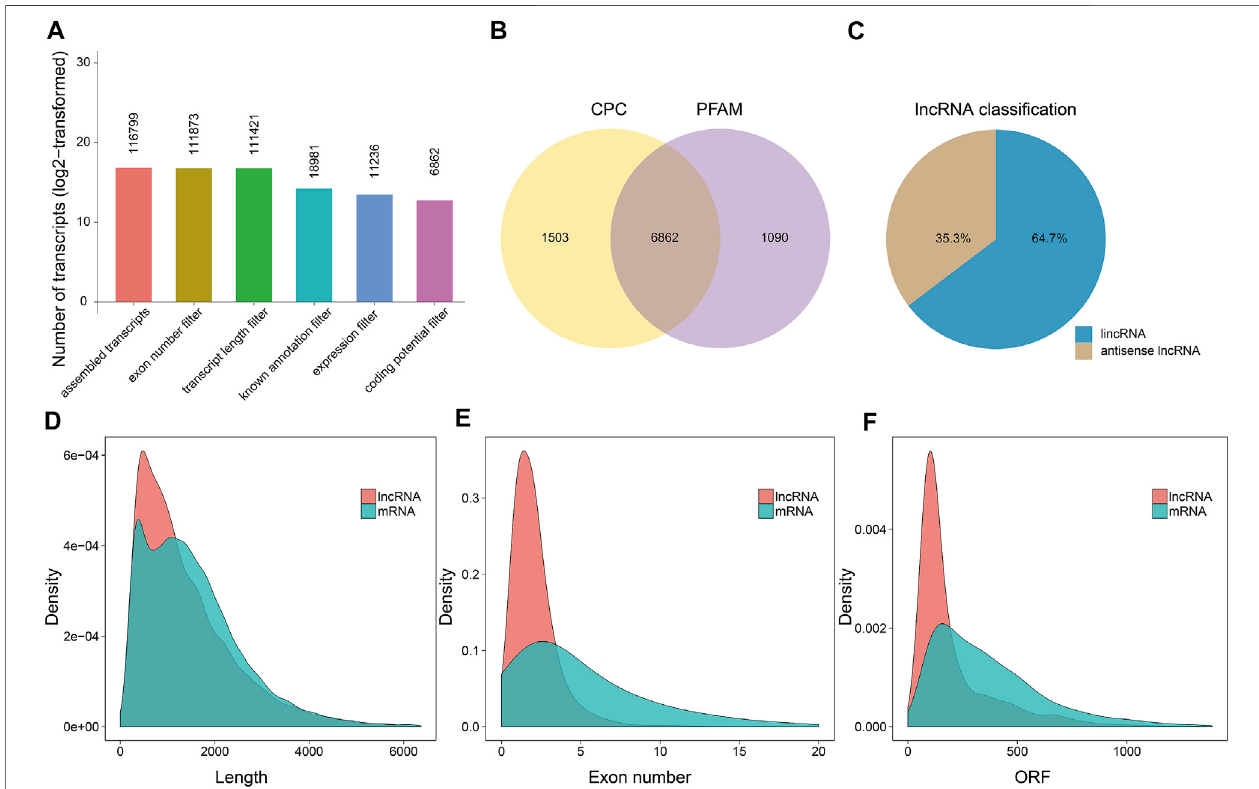
FIGURE 1 | The characterization and identi fi cation of candidate lncRNAs. (A) Identi fi cation of lncRNAs from RNA sequencing data based on the structural characteristics of lncRNAs and the functional characteristics of non-coding proteins with fi ve strict screening conditions. Each number represented the number of transcripts obtained after fi ltering. (B) The Venn diagram of potential candidate lncRNAs by competing with the Coding Potential Calculator (CPC) and the Programmed FrequencyAmplitudeModulation(Pfam)database. (C) Classi fi cationofthepredictedantisenseandintergeniclncRNAs. (D – F) Thelength,exonnumber,andopen reading frame (ORF) distribution of mRNAs and lncRNAs,